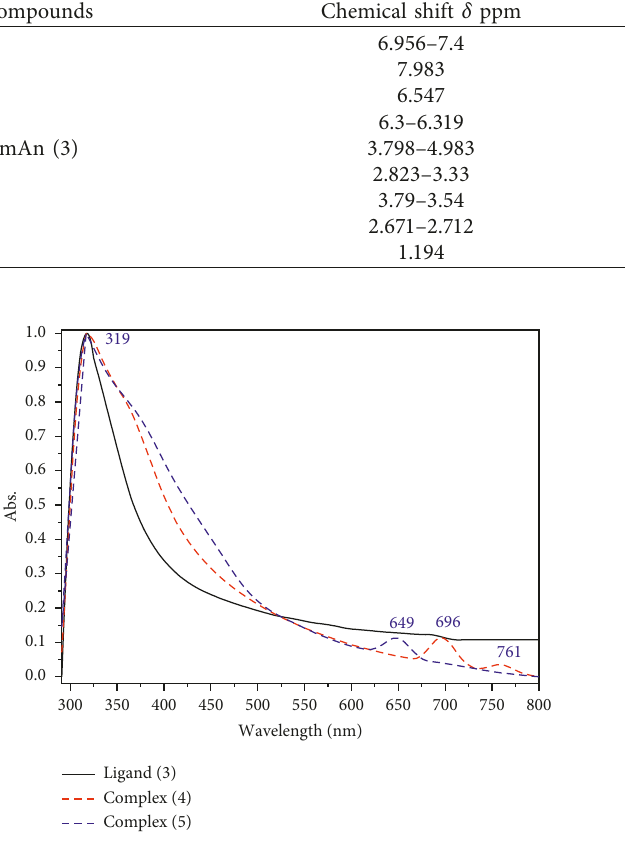
Figure 2: UV/Visible spectrum of the ligand and complexes.